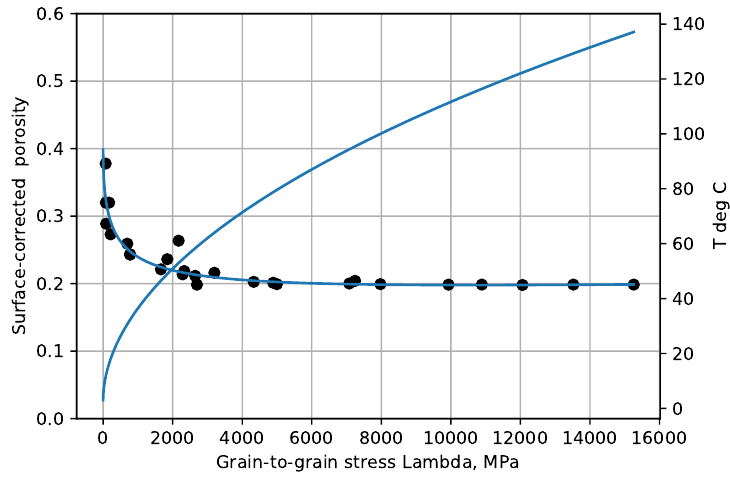
Figure 14. Makran1.